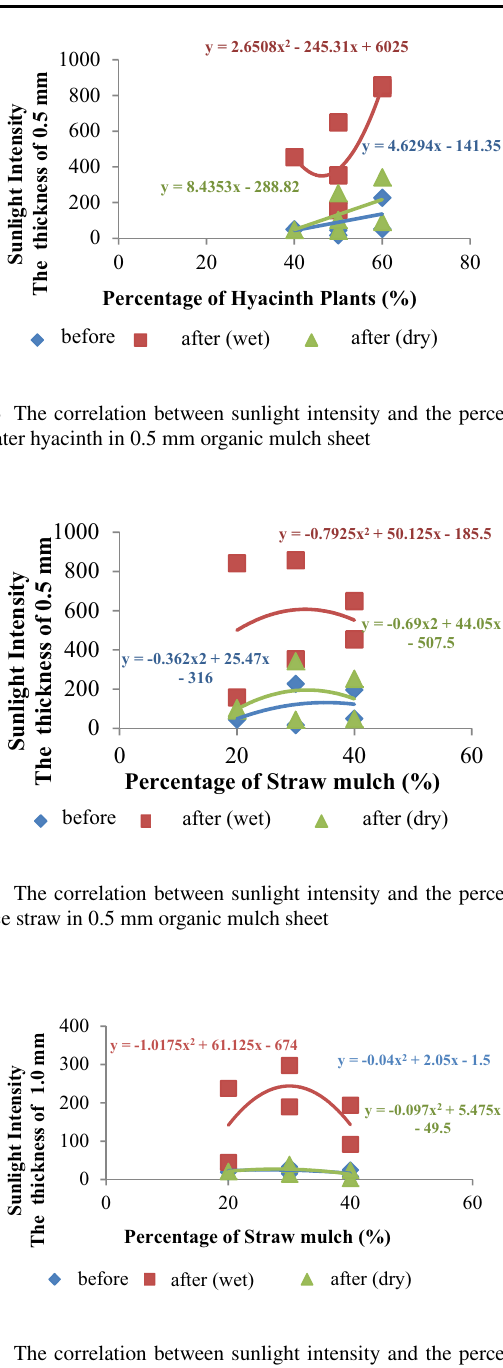
Fig. 6 The correlation between sunlight intensity and the percentage of rice straw in 1.0 mm organic mulch sheet